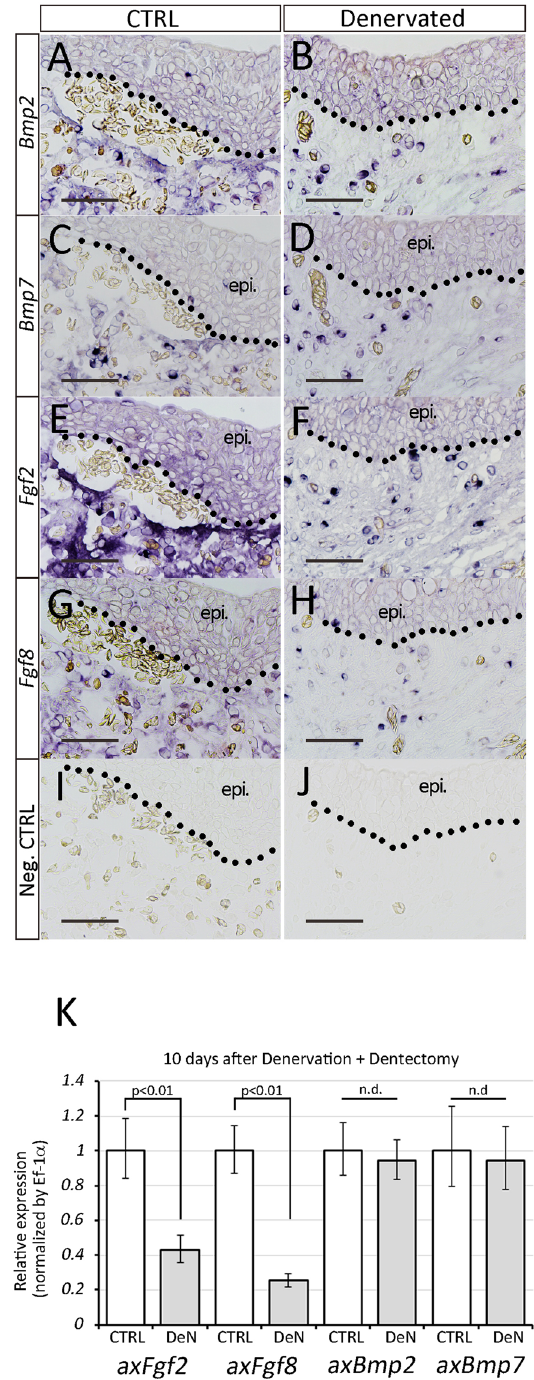
Figure 8. Effects of denervation on gene expression patterns in the axolotl mandible. ( A–J ) Gene expression patterns were investigated by in situ hybridization. (Left column) Control samples. (Right column) Denervated samples (10 days after denervation). Scale bars in A–J are 100 μ m. Neg. CTRL. = negative control. epi. = oral epithelium. A–J have the same magnificatio. Data are representative of 5 axolotl mandibles. (K) Quantitative RT-PCR analysis was performed on the samples 10 days after dentectomy. Gene expression level was compared between the control and denervated samples (n = 4). Statistical analysis was performed with the t -test (two- tailed). DeN = denervated